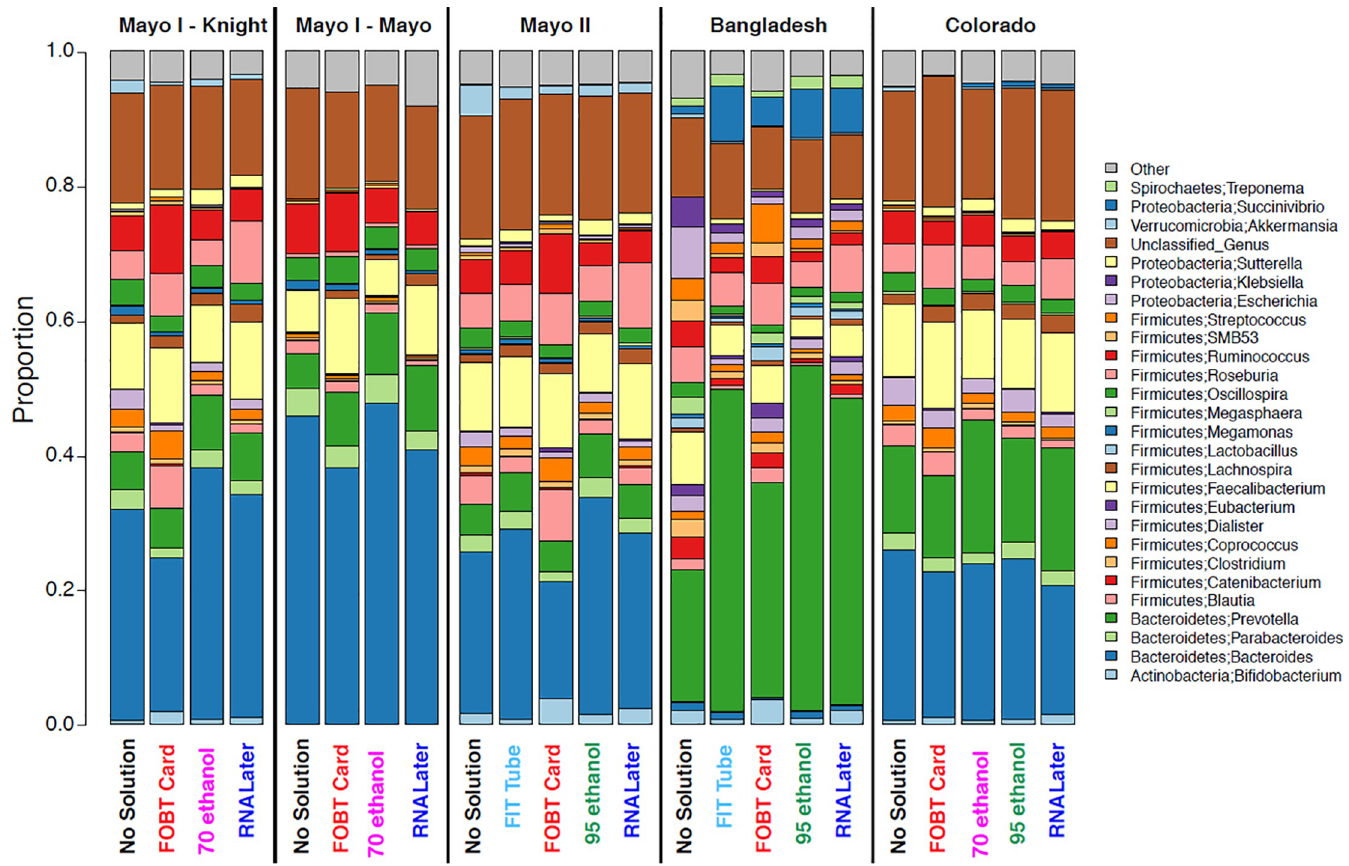
Fig 6. Relative abundance of bacterial genera in fecal samples frozen on day-0, collected from 132 participants in five studies (Mayo 1-Knight lab, Mayo 1-Mayo lab, Mayo 2, Bangladesh, and Colorado). OTU counts were merged across samples by study population and collection method, and relative abundance was calculated for the merged samples. OTUs that could not be assigned to a specific genus were combined into “Unclassified_Genus”. The ‘Other’ group comprised all genera with mean abundance less than 0.5%. Abbreviations : FIT , fecal immunochemical test tubes; FOBT , fecal occult blood test cards; FTA , Flinders Technology Associates cards; OTU , operational taxonomic unit